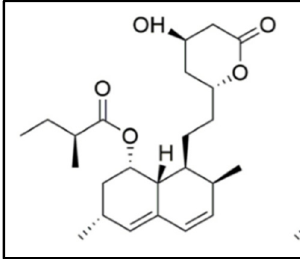
Figure 8. Molecular structure of Monacolin K, also known as Mevinolin or Lovastatin.